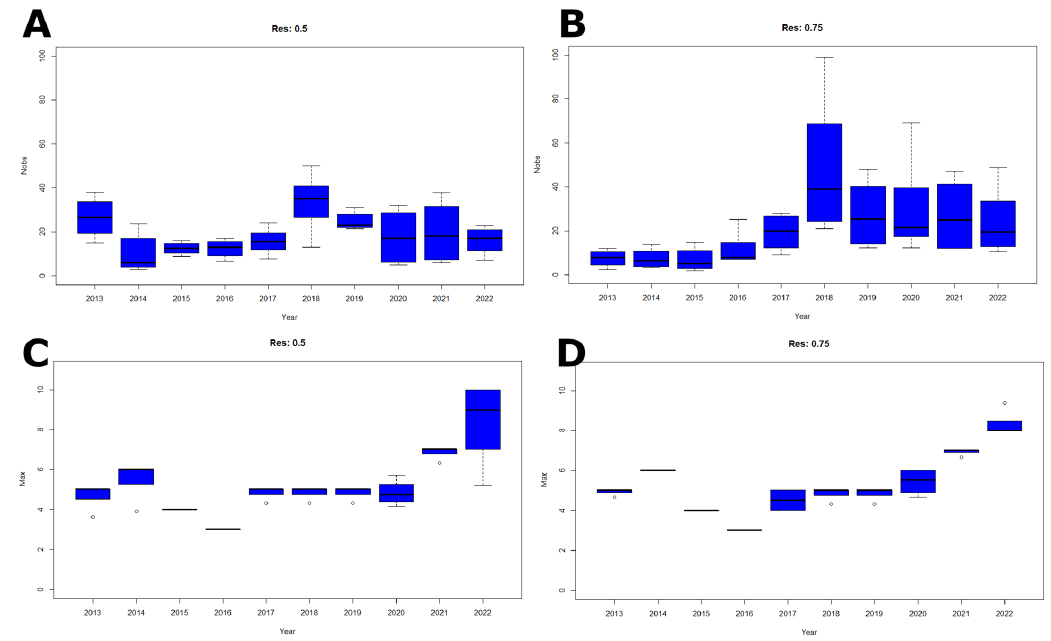
Figure 8. Boxplot of the number of cases (top row) and maximum hail size (bottom row) per year (period 2013–2022) for the four red points of panel A of Figure 3, for the spatial resolution of 0.5° (panels A and C) and 0.75° (panels B and D).